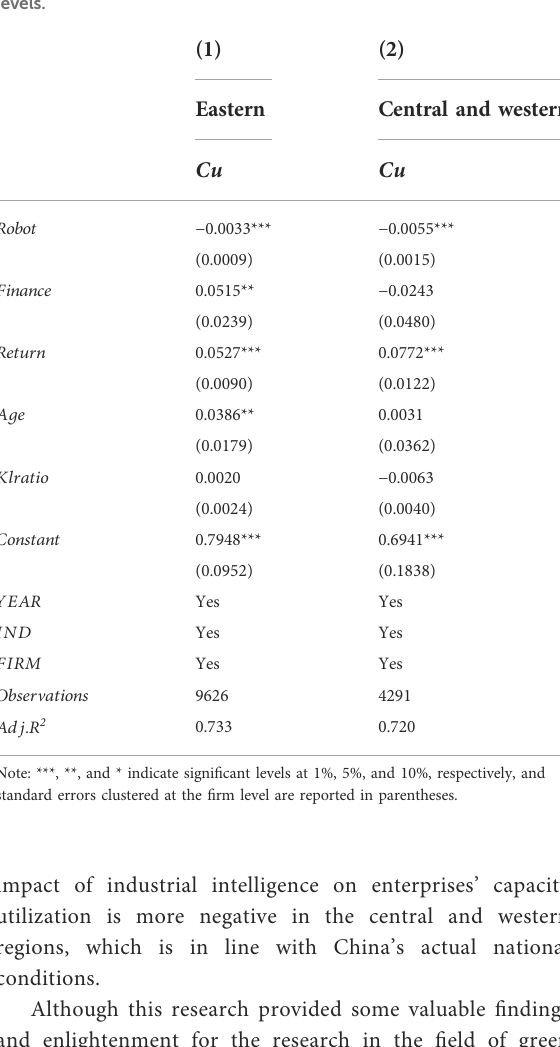
TABLE 8 Heterogeneityanalysisisbasedon characteristics at regional